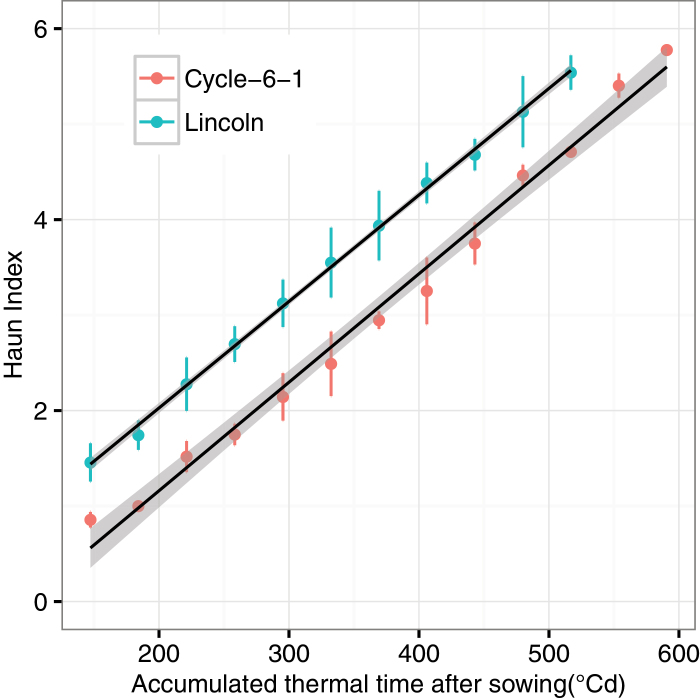
The estimated Haun index for Cycle-6-1 and Lincoln. The black lines are linear regression between the Haun index and accumulated thermal time (y= −1.1+0.0011x, R
2=0.99 for Cycle-6-1; y= −0.2+0.0011x, R
2=1.00 for Lincoln). The error bars indicate the standard deviation from three replicates. (This figure is available in colour at JXB online.)